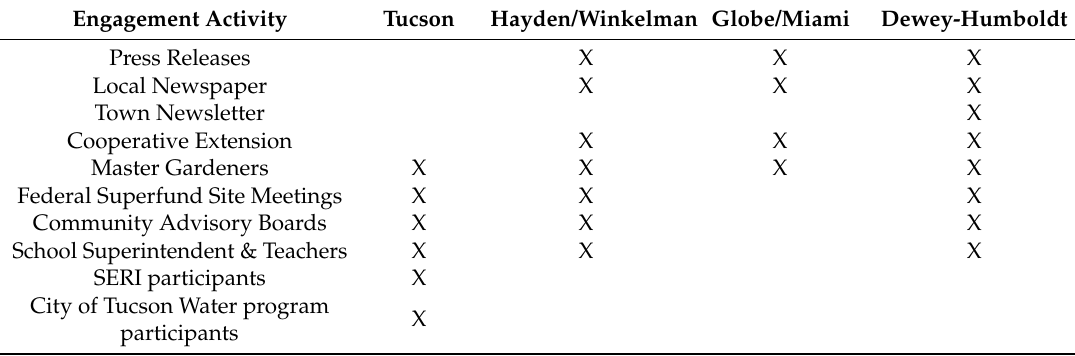
Table 2. Training Participant Engagement Methods by